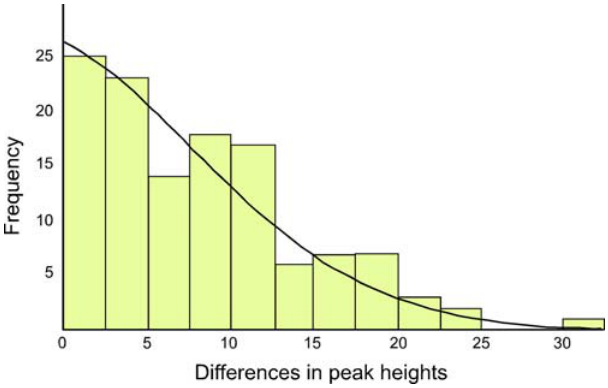
Figure 3. The distribution of differences between the two haplotypes in heteroplasmic mothers and their chicks is shown, as determined by DNA trace peak heights. The curved line represents the prediction of the model, given the estimated number of mitochondria transmitted between mothers and chicks ( N